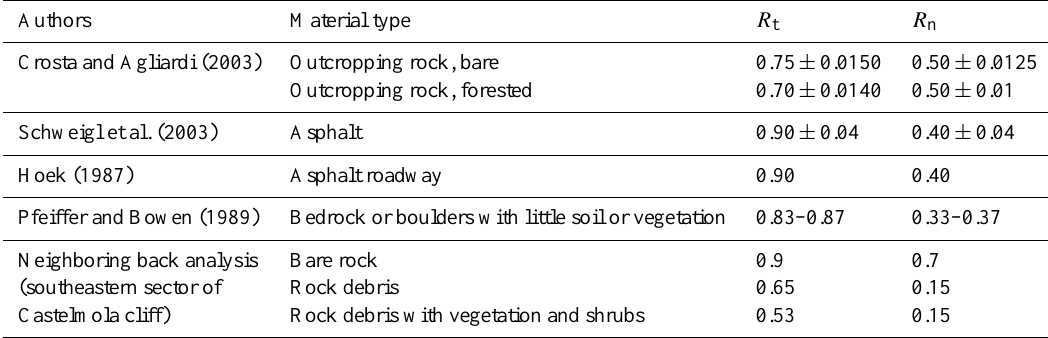
Table 3. Coefficients of restitution applied for rockfall